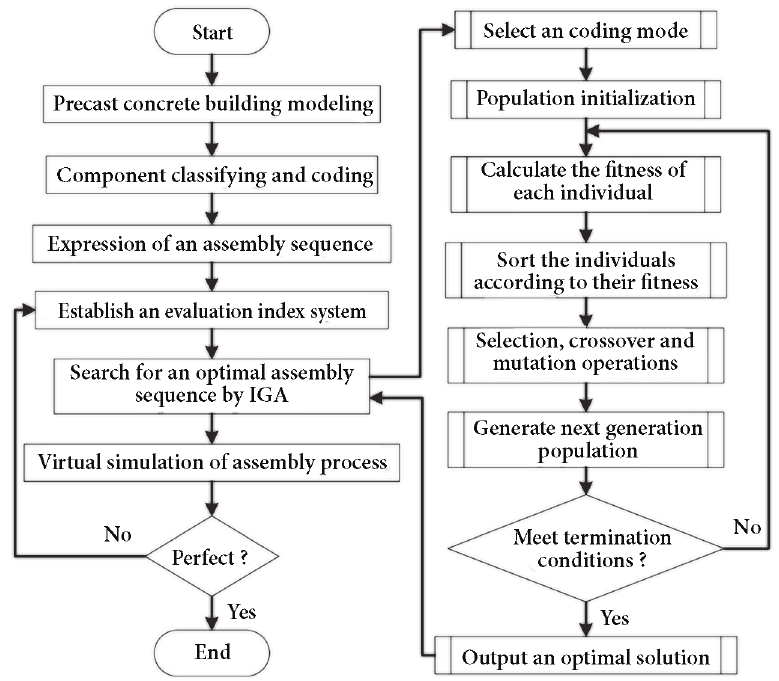
Figure 1. Framework flow chart of BIM-IGA-based ASPO method